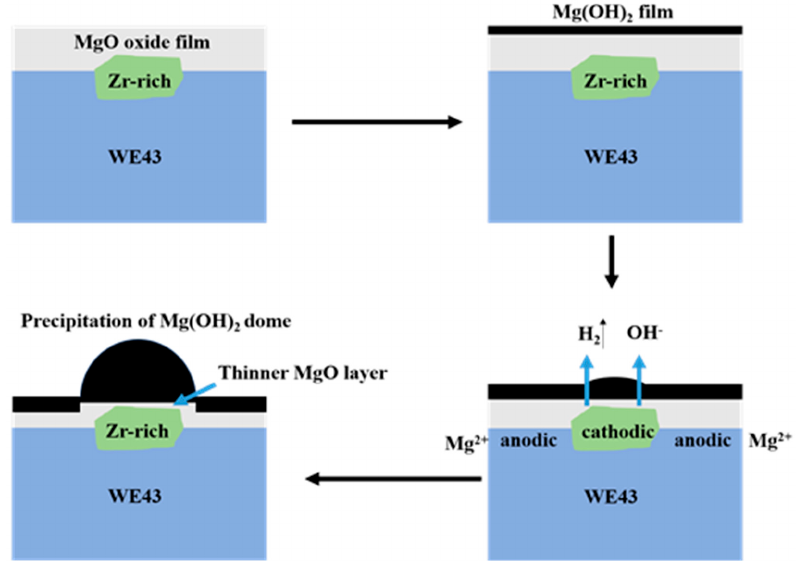
Figure 9. Schematic illustration for the effect of Zr-rich phase on corrosion behavior.